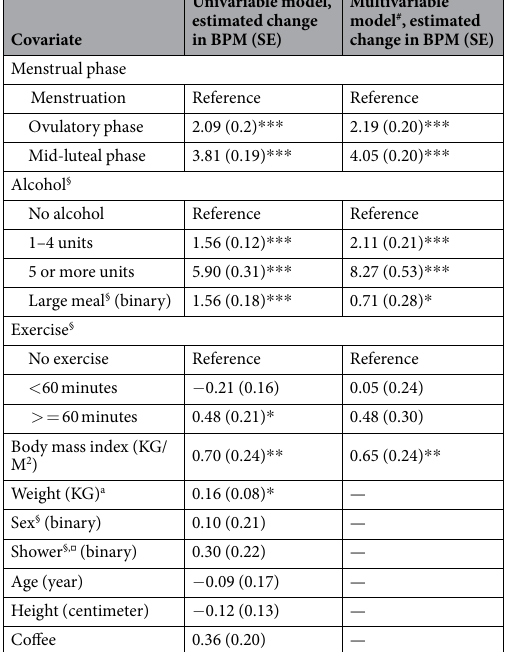
— — Table 1. Uni- and multi-variable mixed effects model of pulse rate and the various physiological phases and the potential confounders (showing estimated change in PR per covariate). # Covariates not-included in the multivariable model are shown with a “ — ” in the table. § Within a four-hour period before sleep. ▫ Data available for participants with device 2 and 3 only. a Given the collinearity between weight and body mass index, only body mass index was included in the multivariable model. * , ** , *** refer to a p-value < 0.05, 0.01, 0.001,